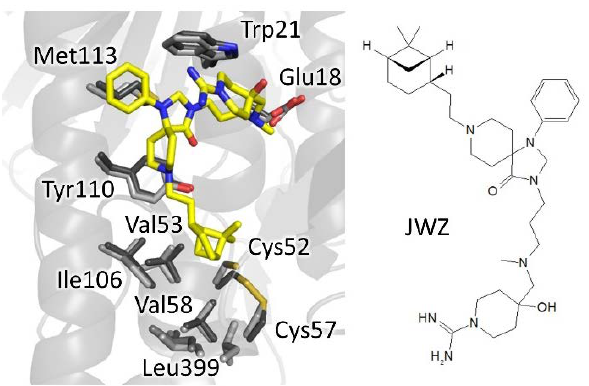
Figure 7. The binding mode of spiro-containing derivative. The phenyl-triazaspiro core seizes the MBS while the bicyclo-heptane moiety accomodates in the hydrophobic sub-pocket. Involved residues are shown as sticks, light grey for inhibitor-free (PDB: 2wow) and dark grey for inhibitor-bound TR (PDB: